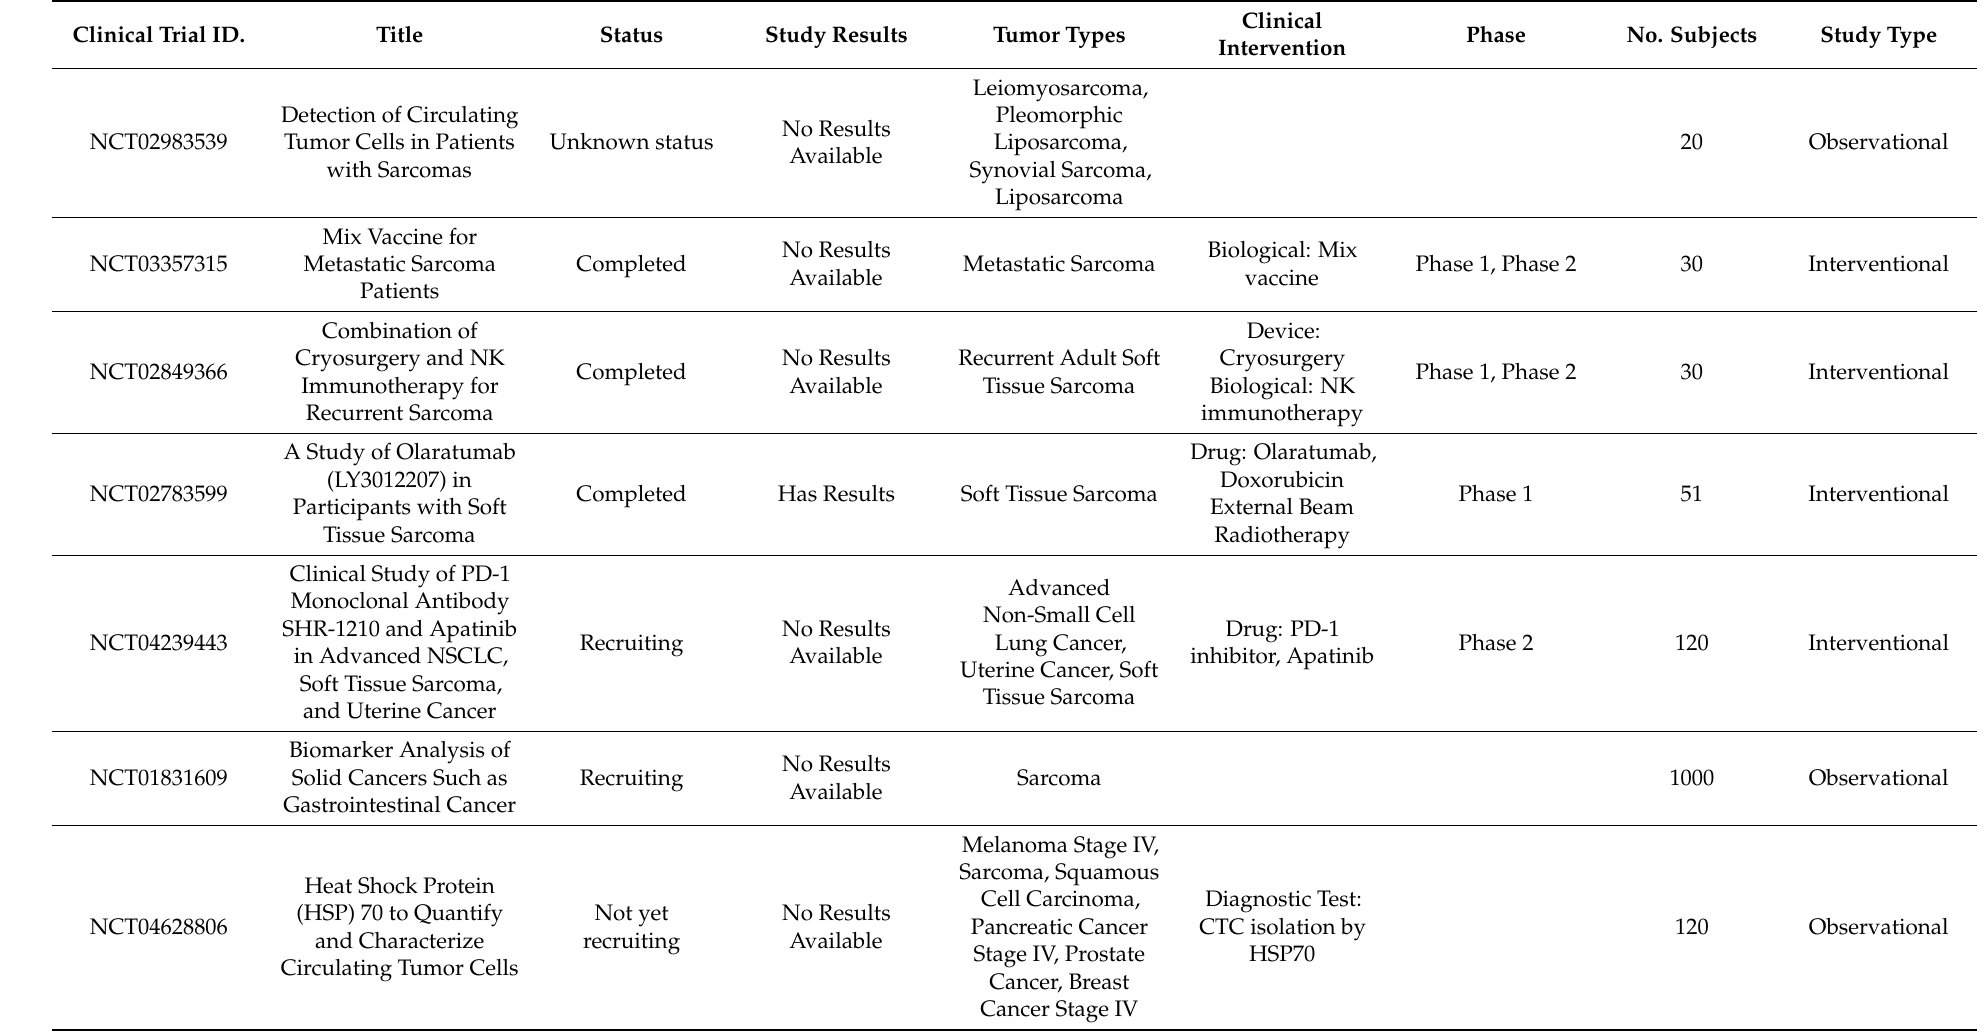
Table 1. Clinical trials including detection of CTCs in sarcoma registered at https://www.clinicaltrials.gov, 1 February 2021. Clinical Trial